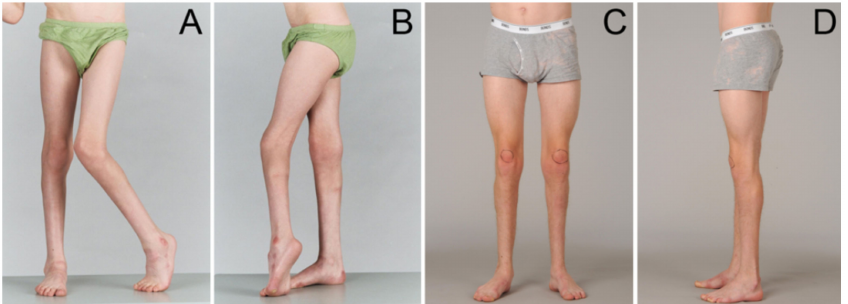
Figure 3. Stage 3 MSP in a 10-year old boy with very asymmetric spastic diplegia, before ( A , B ) and five years after SEMLS. ( C , D ) All the deformities were corrected with conventional SEMLS proce- dures. He had a marked improvement in gait and function with no relapse at five-year follow-up. No additional interventions for spasticity or contractures were